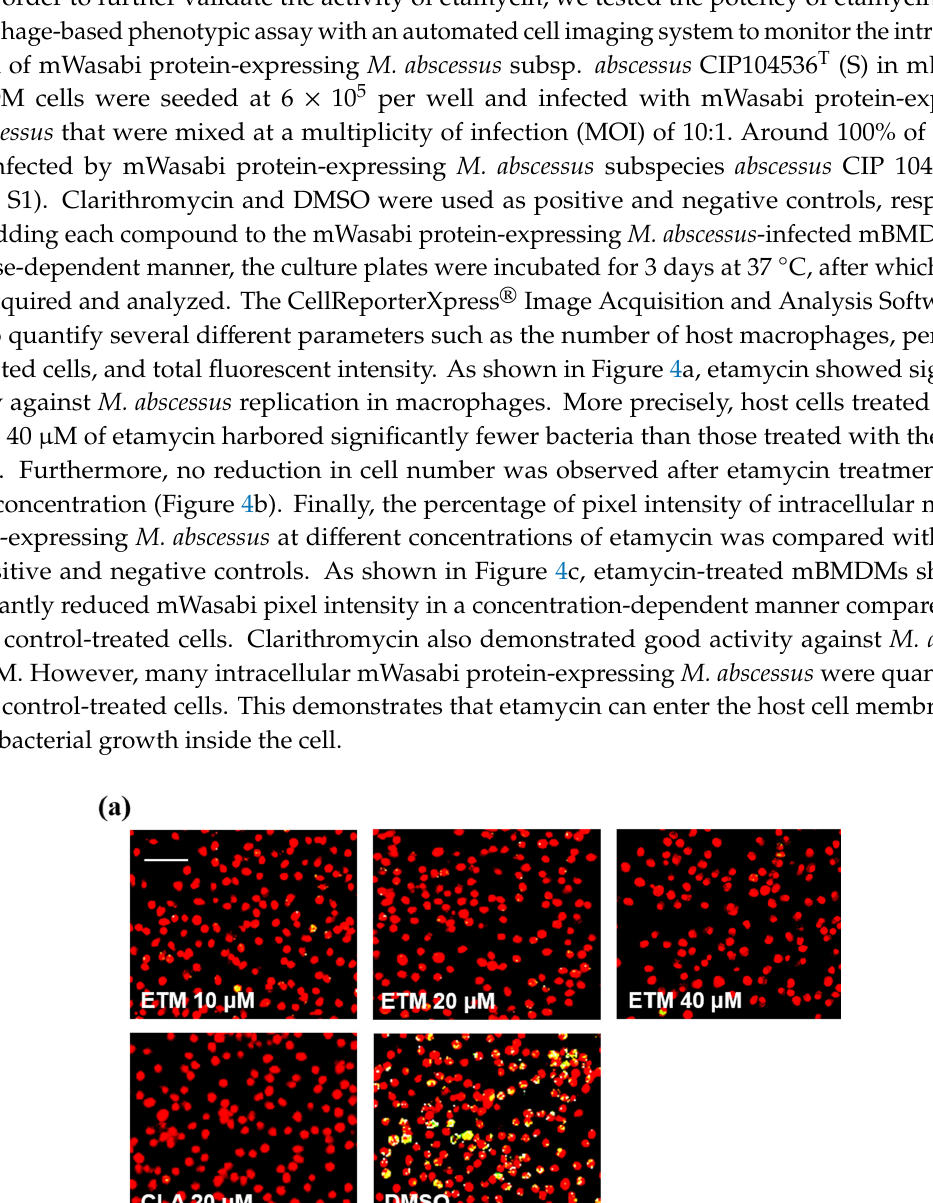
Figure 4. Etamycin intracellular activity in mWasabi protein-expressing M. abscessus -infected mBMDMs. ( a ) Images of mWasabi protein-expressing M. abscessus subsp. abscessus CIP104536 T (S) infected mBMDMs cells on day 3 after treatment with different concentrations of etamycin (10, 20, and 40 μ M). DMSO and clarithromycin at 20 μ M were used as negative and positive controls, respectively. After 3 days, cells were stained with syto60 (red), and the cells were analyzed using the automated cell imaging system. The yellow colors indicated mWasabi protein-expressing M. abscessus that were phagocytized by red-stained mBMDMs. ( b ) The cell number of M. abscessus -infected